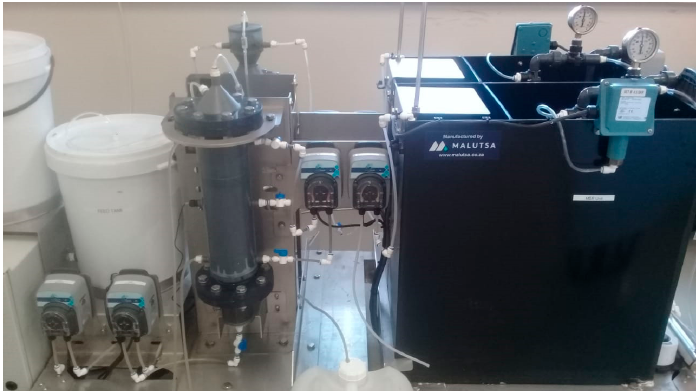
Figure 1. Photograph of the modified down-flow expanded granular bed reactor (DEGBR) (source: D.N. Dlamini).